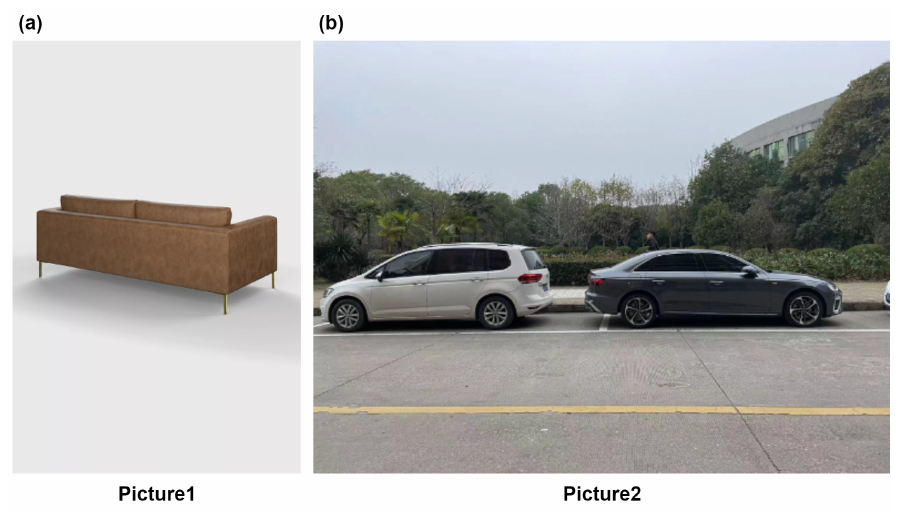
Figure 3. The images used for cloud manufacturing.